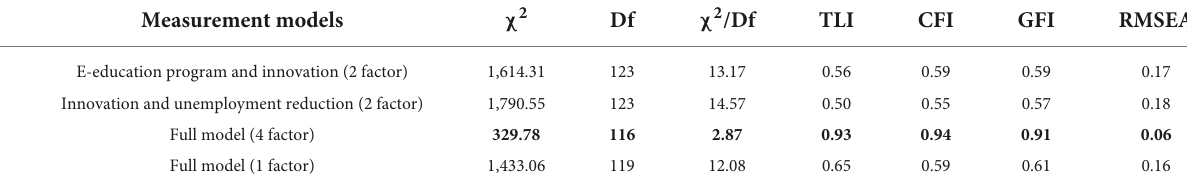
TABLE 1 Measurement model comparison.